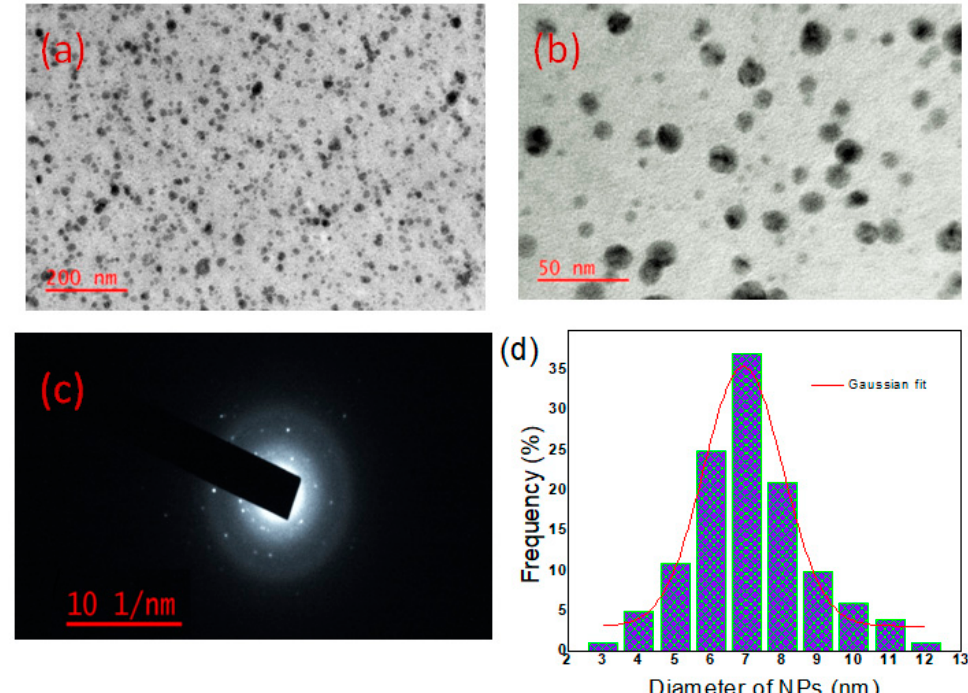
Figure 2. TEM images of AgNPs synthesized by commercial milk. ( a ) At lower magnification; ( b ) at higher magnification; ( c ) SAED pattern of the AgNPs showing concentric rings indicate the high crystallinity of the NPs and ( d ) particle size distribution histogram with a Gaussian curve fitting.